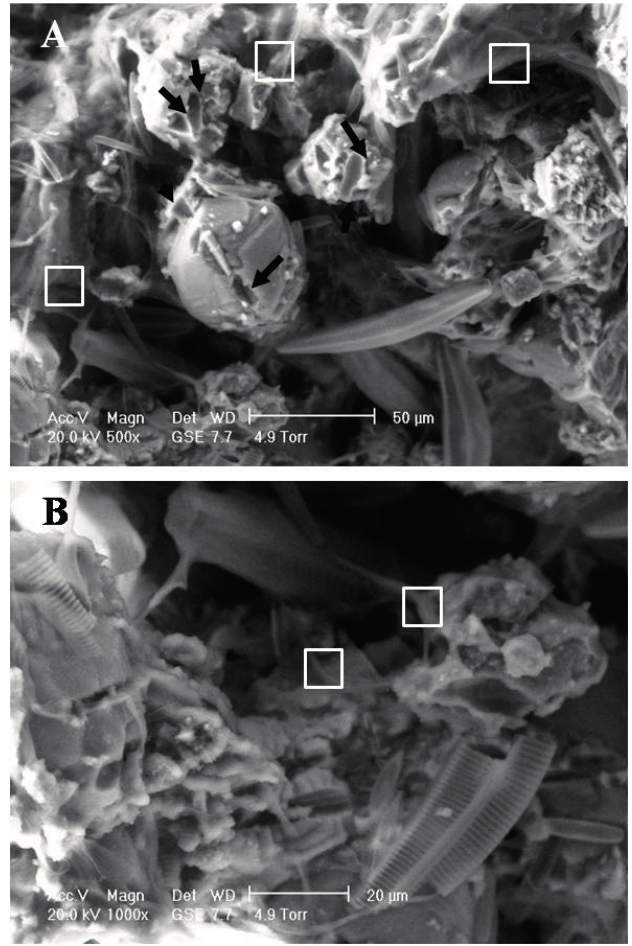
Figure 2. ESEM observation of a travertine sample, collected from the site shown in Figure 1D. Panels ( A ) and ( B ) show that the travertine surface was dominated by psychrophilic diatoms. Their metabolic activity has strong effects on the travertine surface as arrows indicated. Squares in Figure 2 indicate glutinous layers.